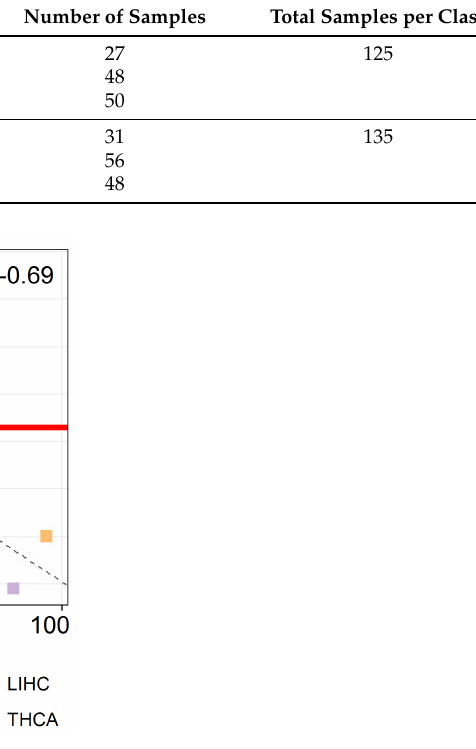
Figure 1. Correlation of subnetwork entropies vs. 5-year OS for p = 0.025 with GDC RPKMupper + Log2 (source: